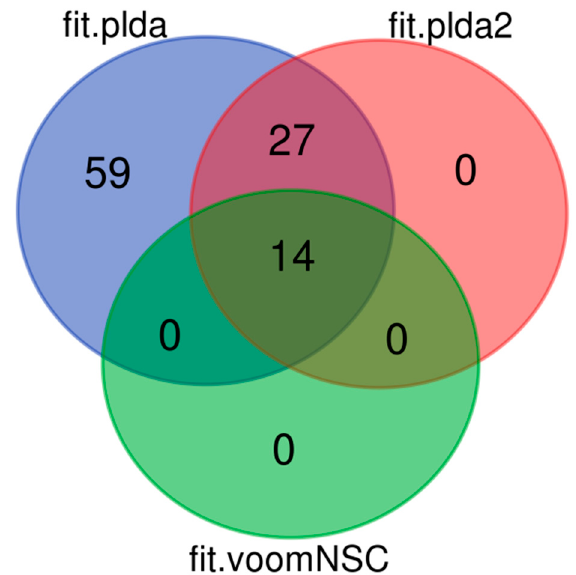
Figure 4. Venn diagram showing the number of common and unique miRNAs associated with cold tolerance predicted by ML models PLDA, PLDA2, and VoomNSC using 325 selected features from published miRNAs data related to cold tolerance in S. commersonii .